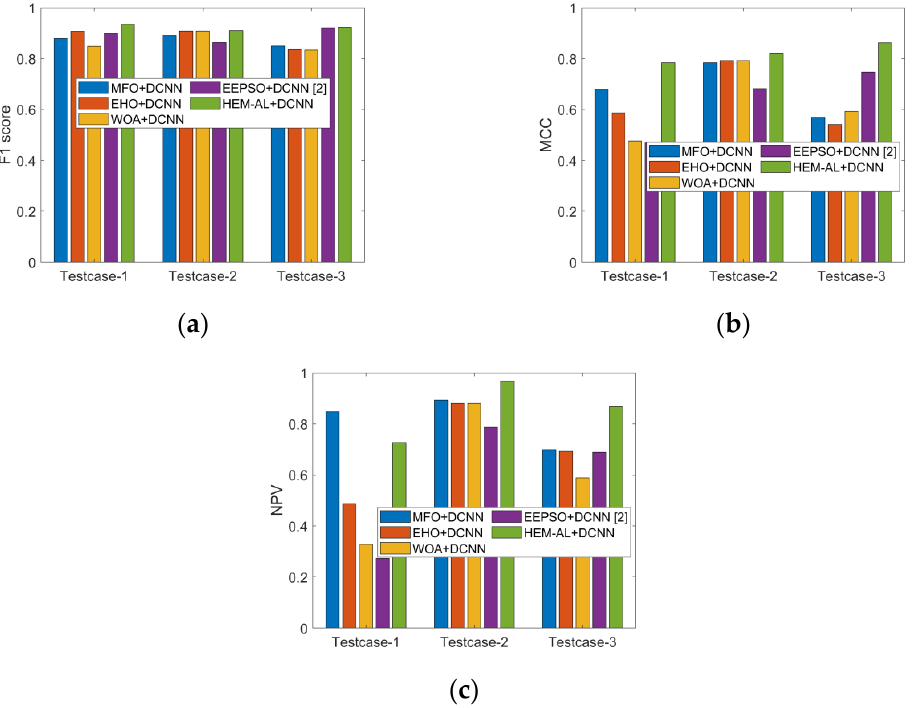
Figure 6. Performance of the proposed method over traditional models for ( a ) F1-score ( b ) MCC ( c ) NPV.